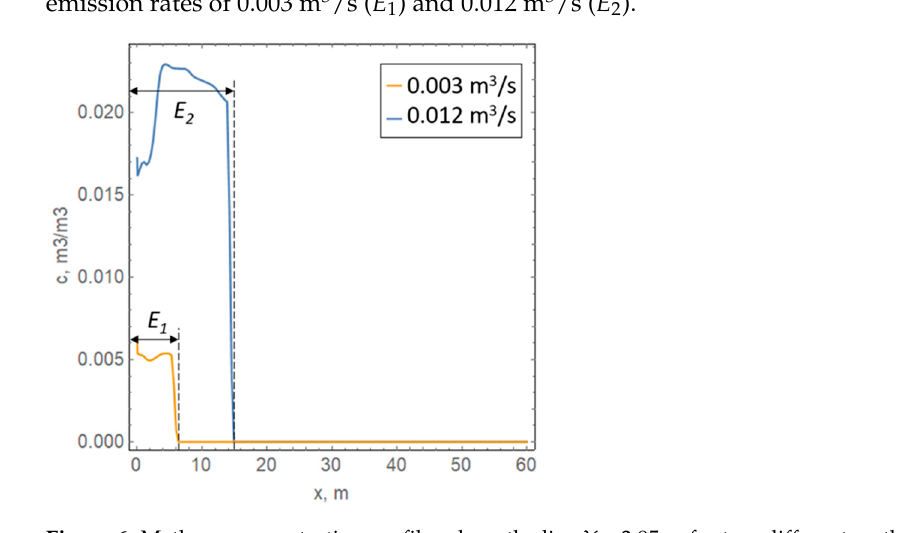
Figure 7. Methane cloud length E as a function of air velocity for four different methane emission intensities; the dots show the numerical solution, the solid lines show the approximating function (20). In general, all the curves exhibit a pronounced non ‐ linear dependence on air veloci ‐ ty and a linear dependence on the methane emission rate. Notably, as the air velocity in ‐